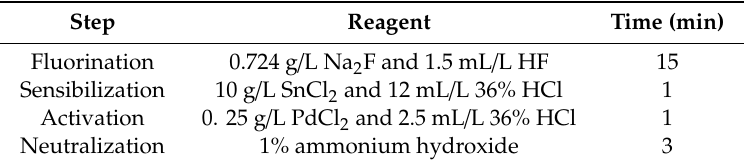
Table 3. Steps of surface pretreatment for PPY / Ti